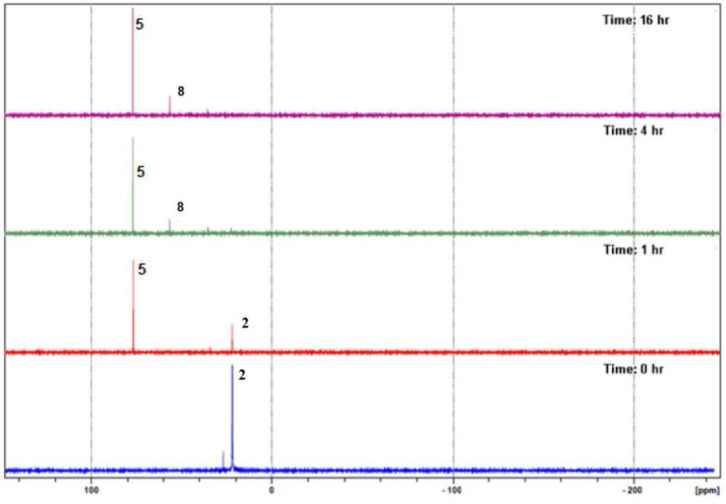
In situ
31P{1H} NMR spectroscopy monitoring of the reaction between 2 and [Ir(C5Me5)Cl2]2.